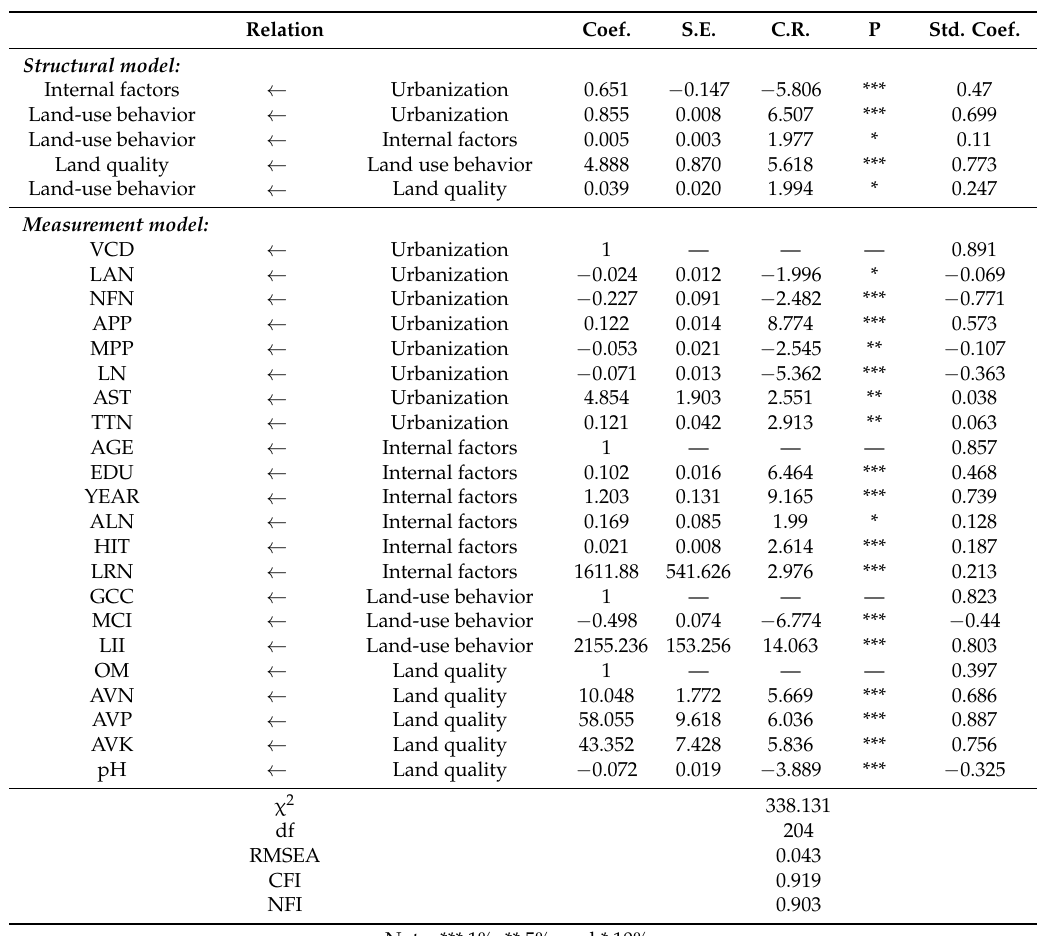
Table 2. Model path coefficient estimation results.